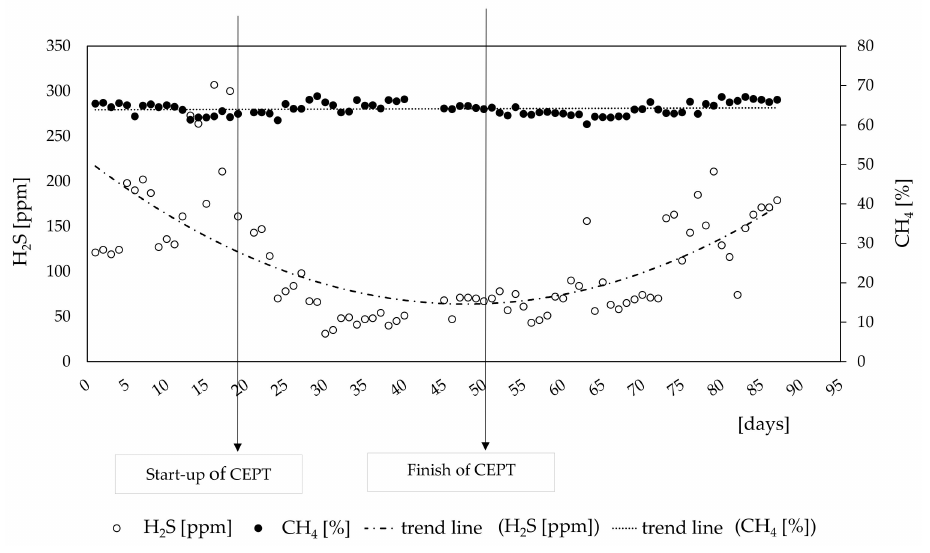
Figure 3. Biogas quality during full-scale